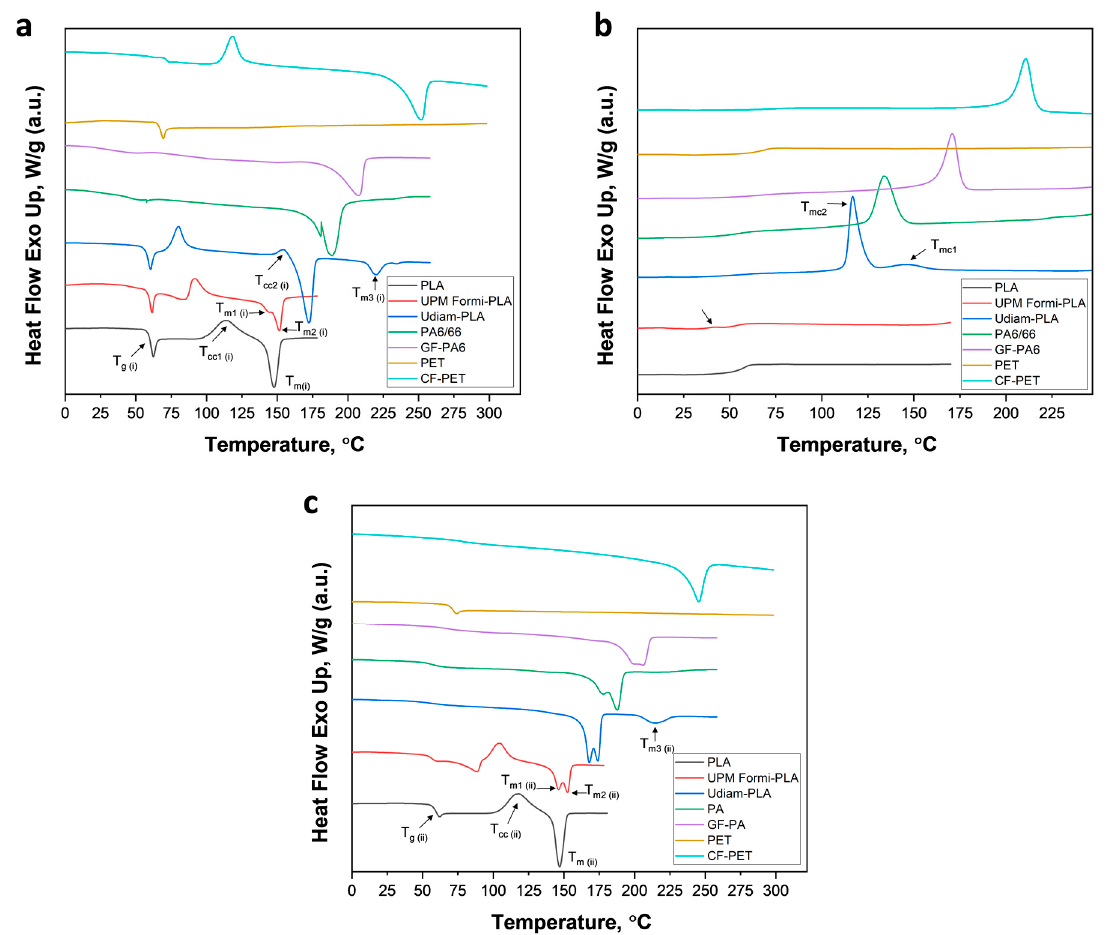
Figure 4. Non-isothermal differential scanning calorimetry (DSC) curves for different printing filaments showing ( a ) first heating cycle, ( b ) cooling cycle and ( c ) second heating cycle.